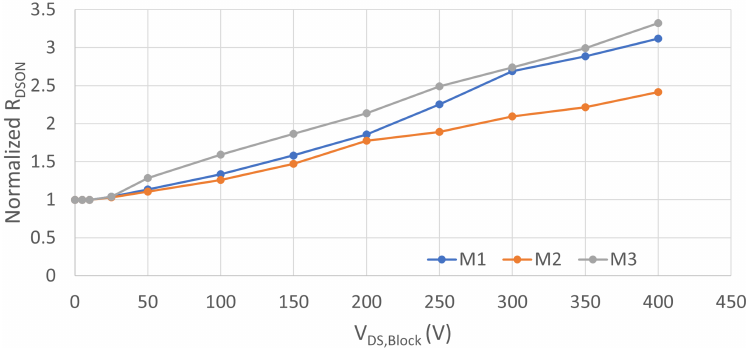
Figure 12. Normalized R DS , ON evaluated at the end of ON-time for the M1, M2, and M3 samples.